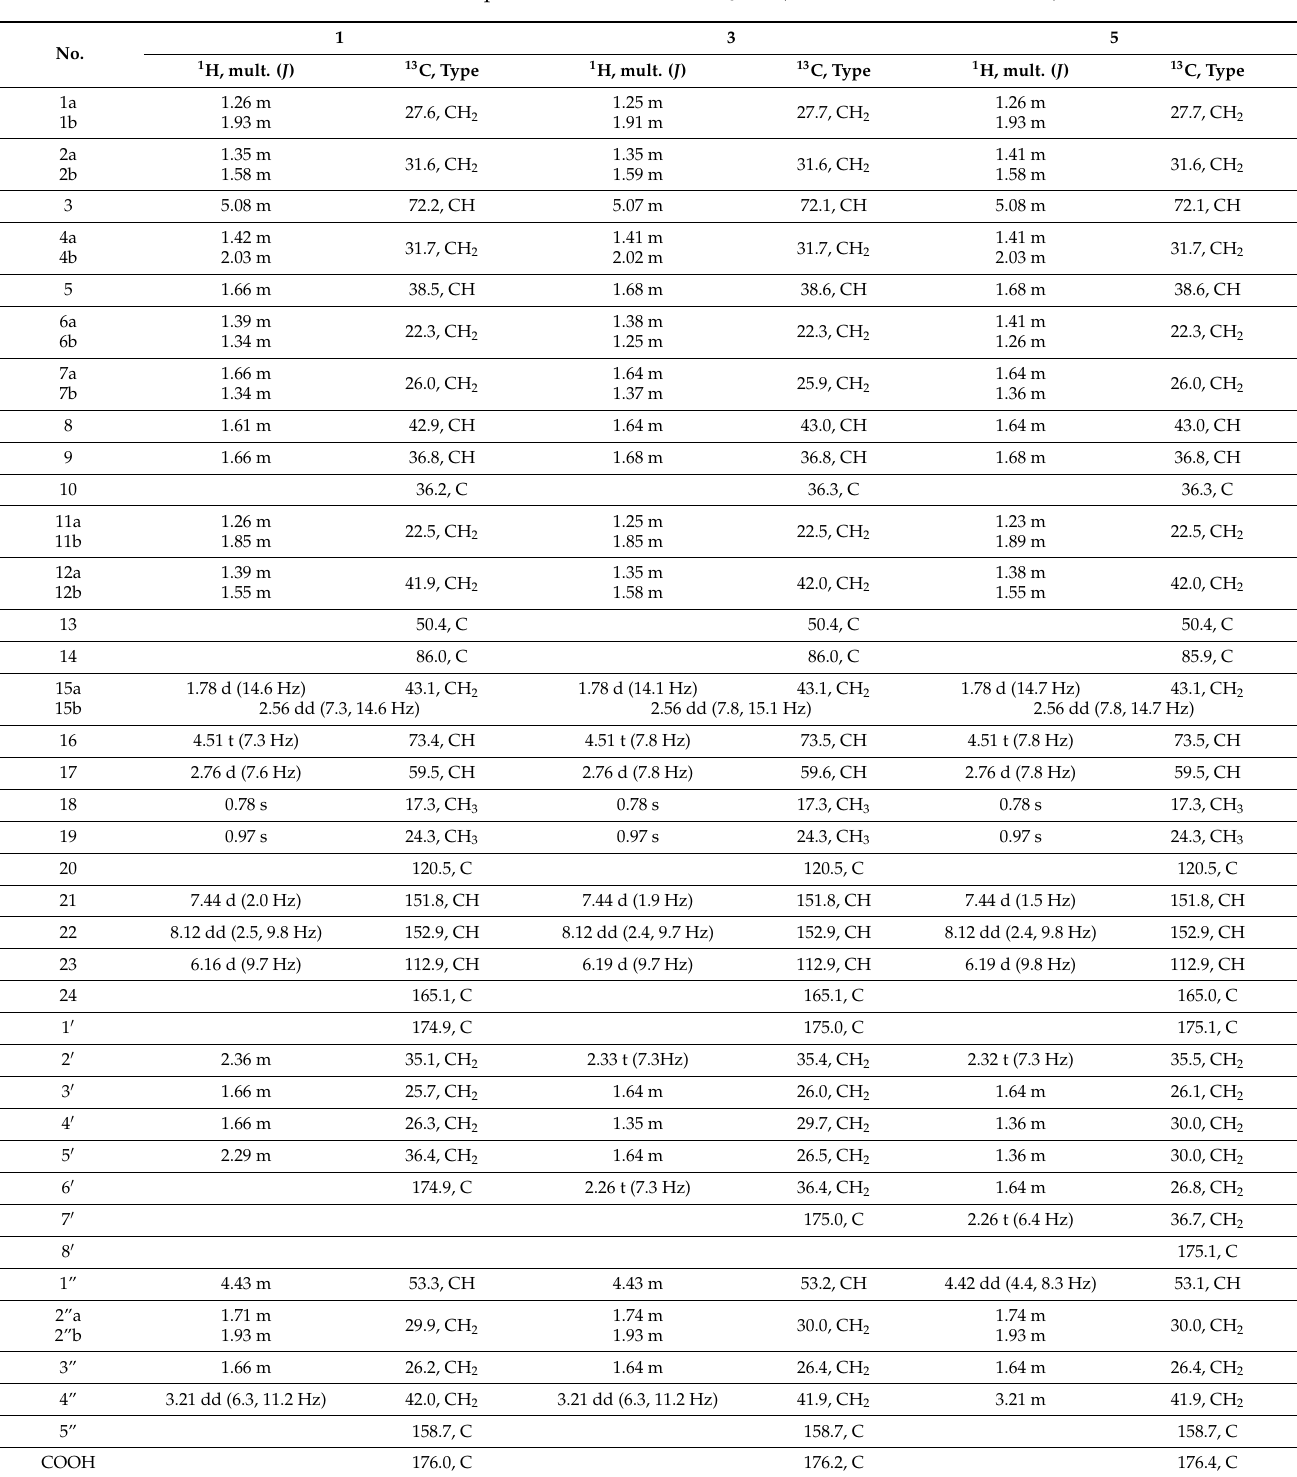
Table 1. NMR data for compounds 1 , 3, and 5 in CD 3 OD ( 1 H 400 MHz, 13 C 100 MHz)